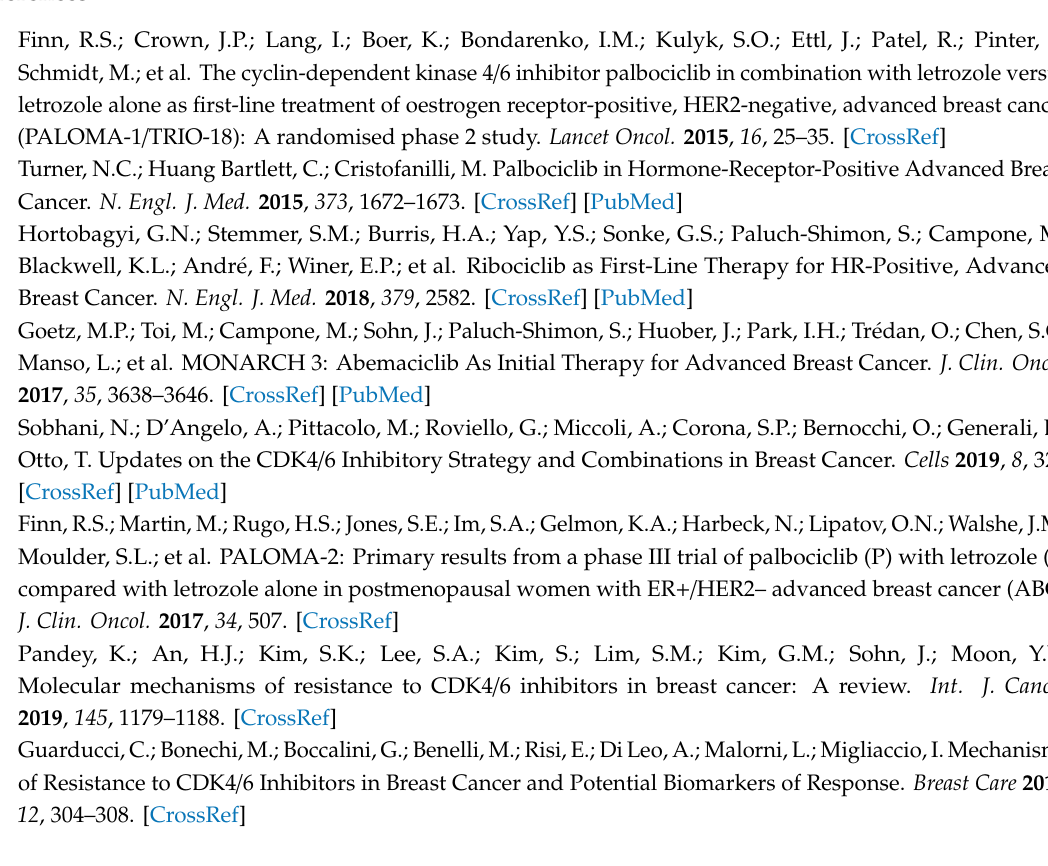
Figure S1: ER + / HER2 − MCF7 cells recapitulate the metabolic behaviour of the ER + / HER2 − breast cancer cells; Figure S2: PDR cells are re-sensitised to palbociclib when glycolysis is targeted; Figure S3: Targeting glycolysis alone or in combination with PD in ER + / HER2 + PDS cells has no major impact when compared to palbociclib alone; Figure S4: Commonly deregulated metabolites between the di ff erent PDR cell lines; Figure S5: Aerobic glycolysis is enhanced in ER + / HER2 + and reduced in ER + / HER2 − PDR cells when compared to PDS cells; Figure S6: TCA intermediates are enhanced in ER + / HER2 − and reduced in ER + / HER2 + PDR cells when compared to PDS cells; Table S1: Di ff erentially expressed m / z entities between the di ff erent PDS and PDR cell